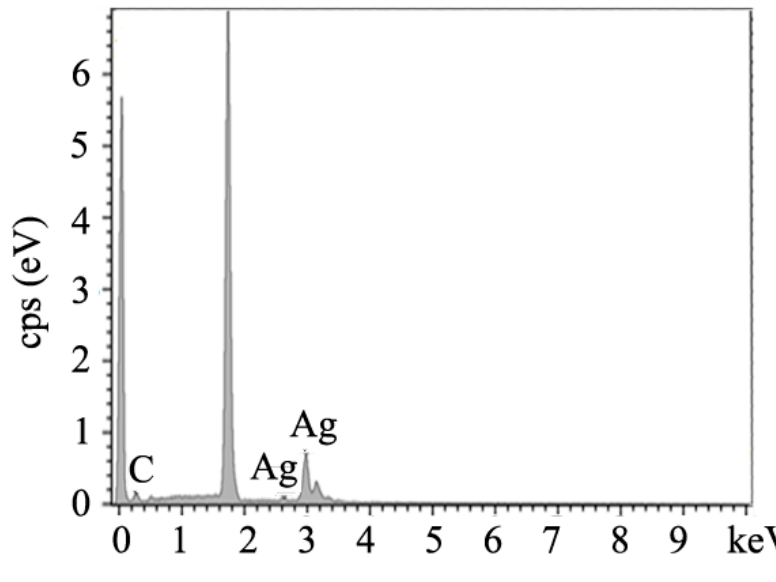
Figure 3. EDS spectrum of Ag@CNTs.